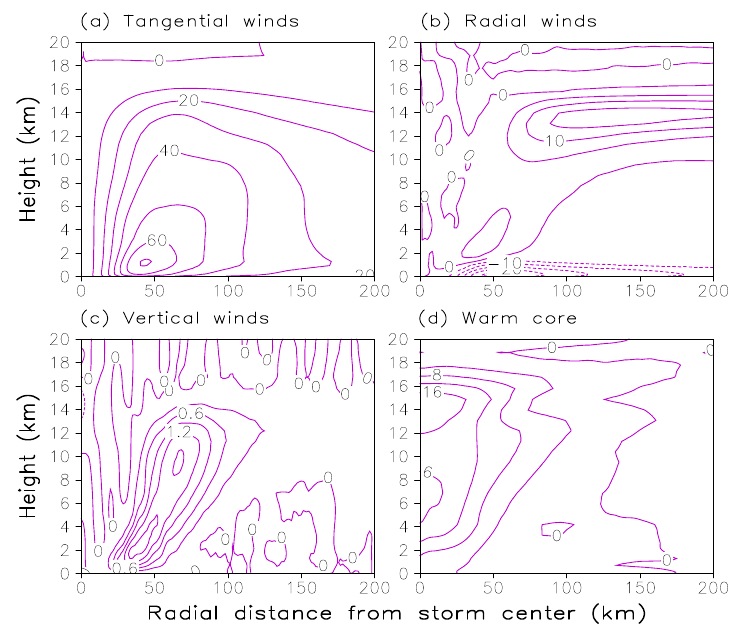
Figure 2. Height-radius cross-sections of azimuthal mean ( a ) tangential winds (m s − 1 ), ( b ) radial winds (m s − 1 ), ( c ) vertical winds (m s − 1 ), and ( d ) potential temperature anomalies (K) averaged between 108 and 120 h. The panels ( a – c ) incorporate the information in Figure 1b of Ma et al. (2015) [26], but are vertically extended to 20 km since an integration from model bottom to model top ( 20 km) is used in the following budget